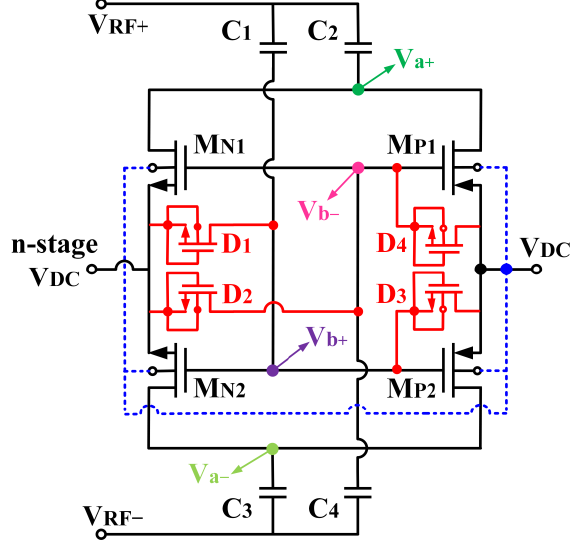
Figure 2. Schematic of the designed CCDD rectifier.